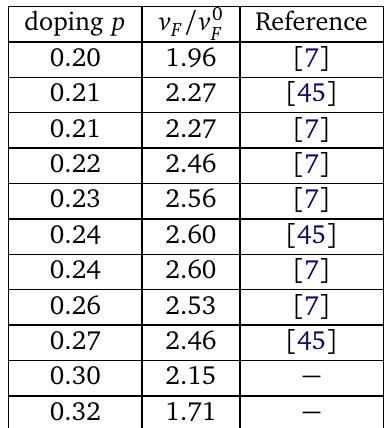
Table 9: Renormalisation factors for the Fermi velocity of LSCO where v 0 from ARPES-derived tight-binding Fermi surfaces [ 40 ] and v required to match the as-measured normal-state electronic specific heat γ 52 ] .